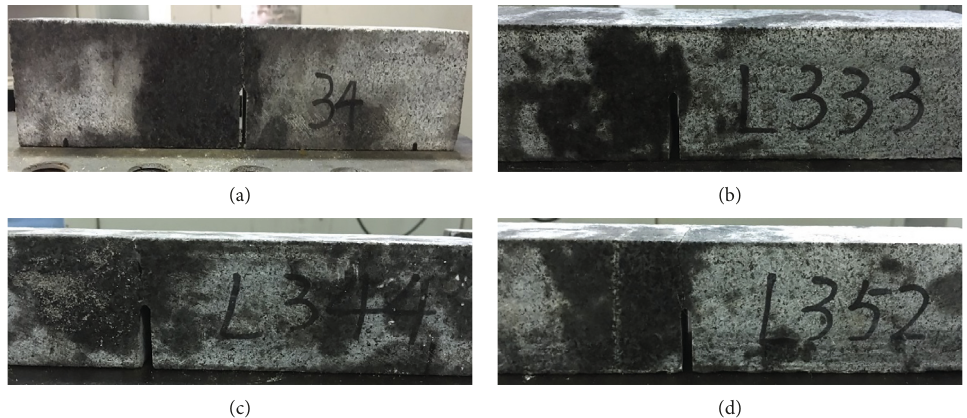
Figure 12: Three-point bending samples subjected to freeze-thaw cycling and mechanical testing: (a) 20 ° C; (b)